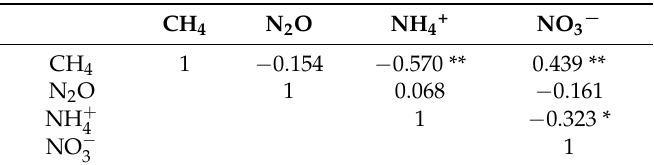
Table 3. Pearson correlation between greenhouse gas emissions and soil inorganic N concentrations in the paddy fields.